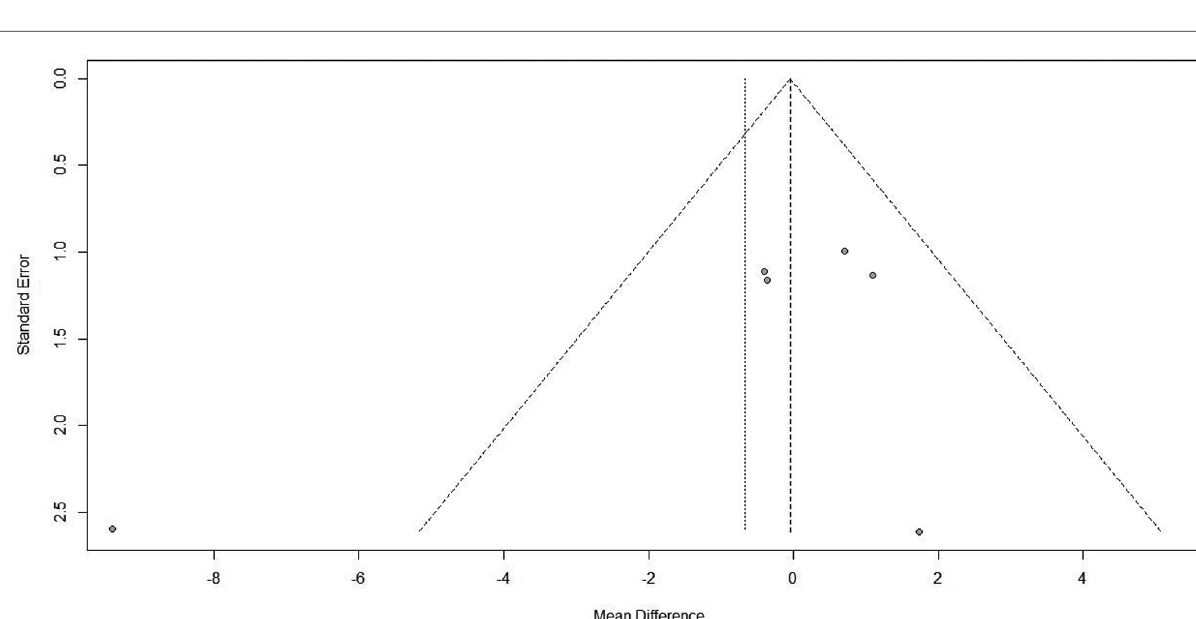
FIGURE 8 | Funnel plot of fasting blood glucose indicators after blood glucose control during